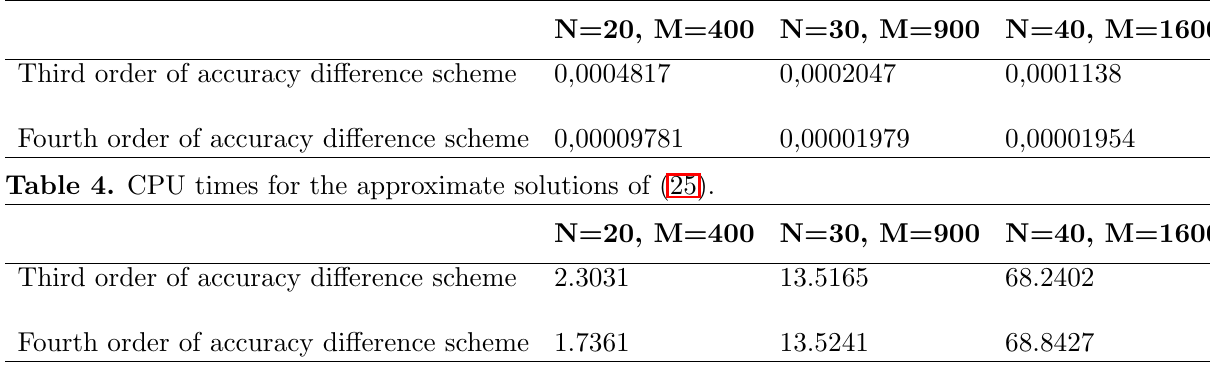
Table 3. Error analysis for the approximate solutions of (25).